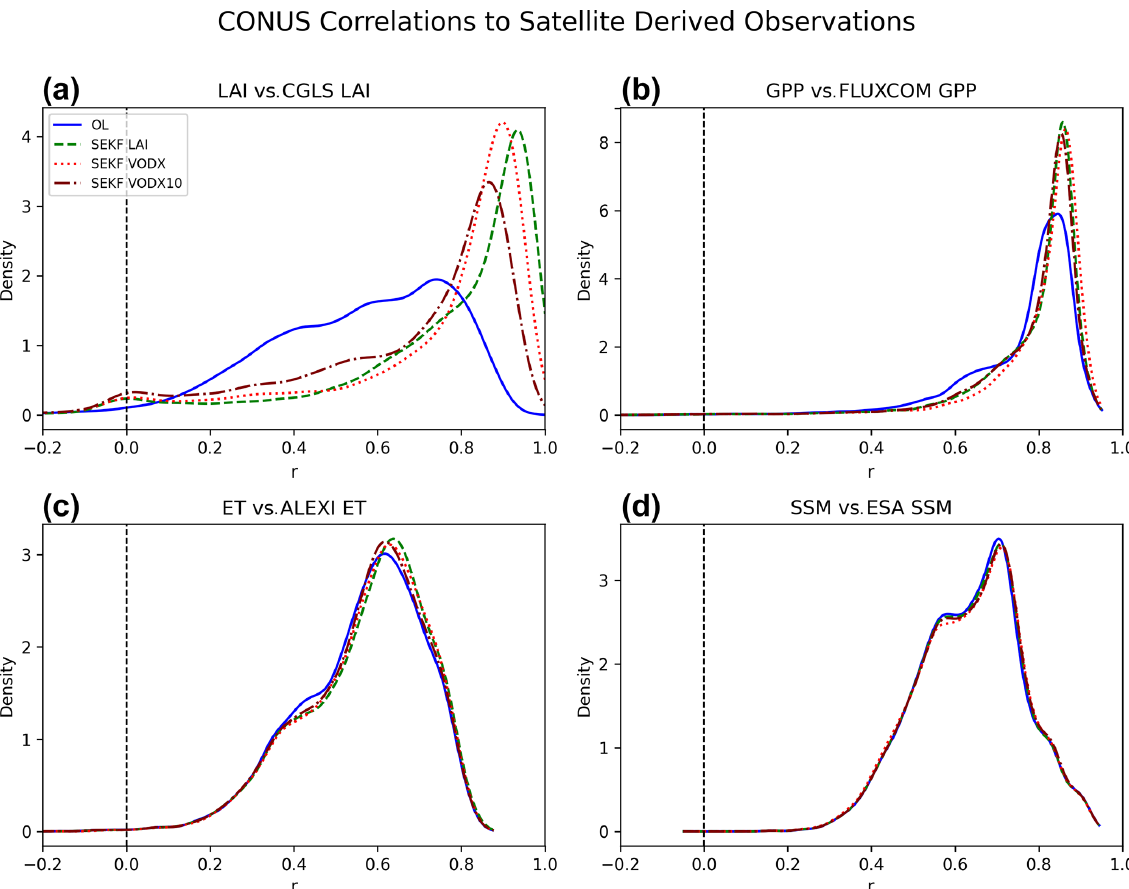
Figure 8. Graphs of probability distribution function (PDF) correlation distributions over CONUS between the LDAS-Monde OL (solid blue line), SEKF LAI (dashed green line), SEKF VODX (dotted red line), and SEKF VODX10 (dash-dotted maroon line) and satellite-derived observations of (a) LAI (2003 to 2018), (b) GPP (2003 to 2013), (c) ET (2003 to 2018), and (d) SSM (2003 to 2018). The PDFs were calculated using a Gaussian kernel density estimation of the scores. The kernel density estimation smoothing bandwidth is calculated using the default Scott’s rule.